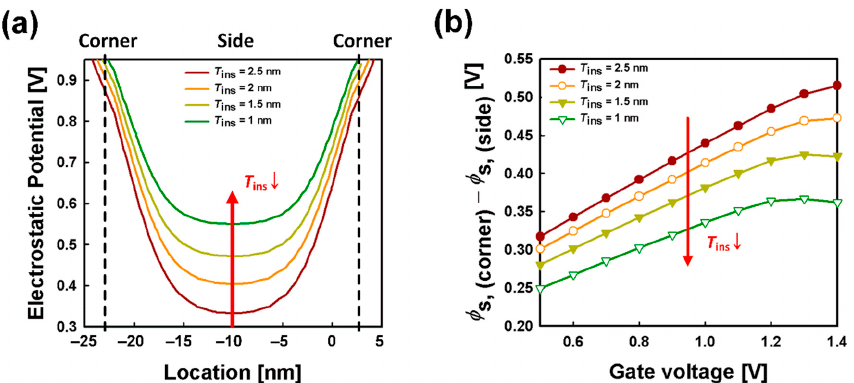
= 1 V; ( b ) Surface potential